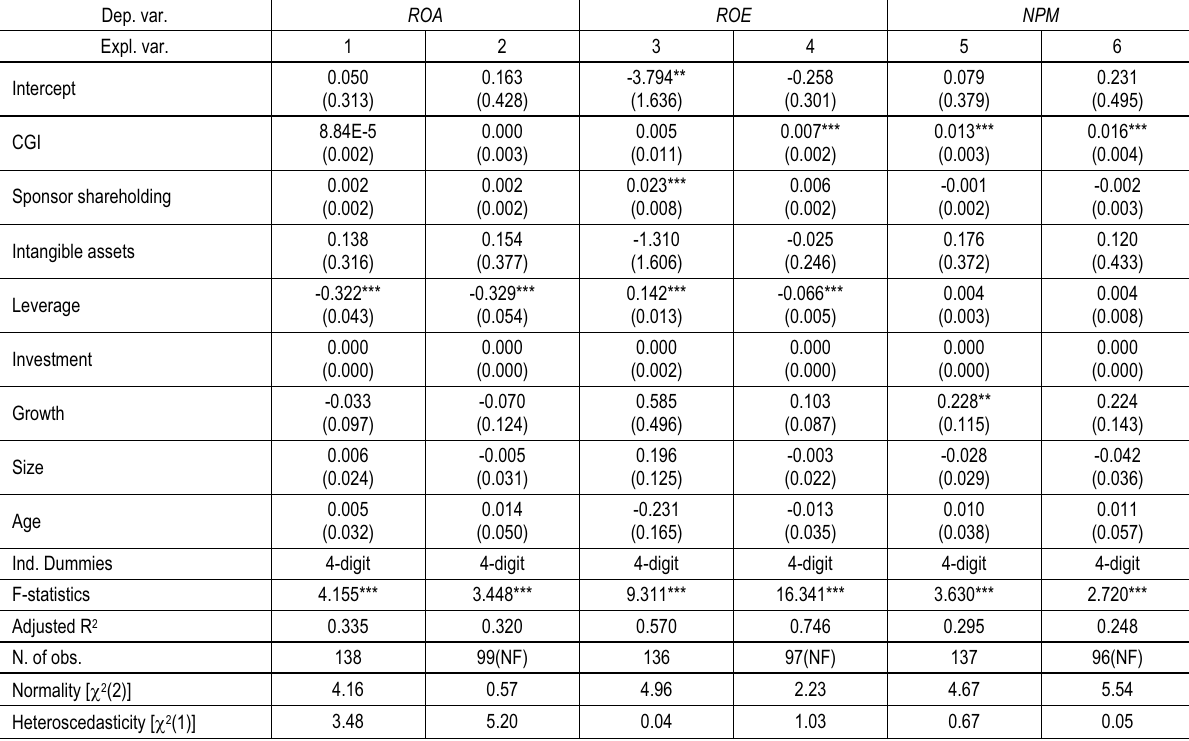
Table 5. OLS regression results of ROA, ROE and NPM against the corporate governance index (CGI) Dep. var. ROA ROE NPM Expl.